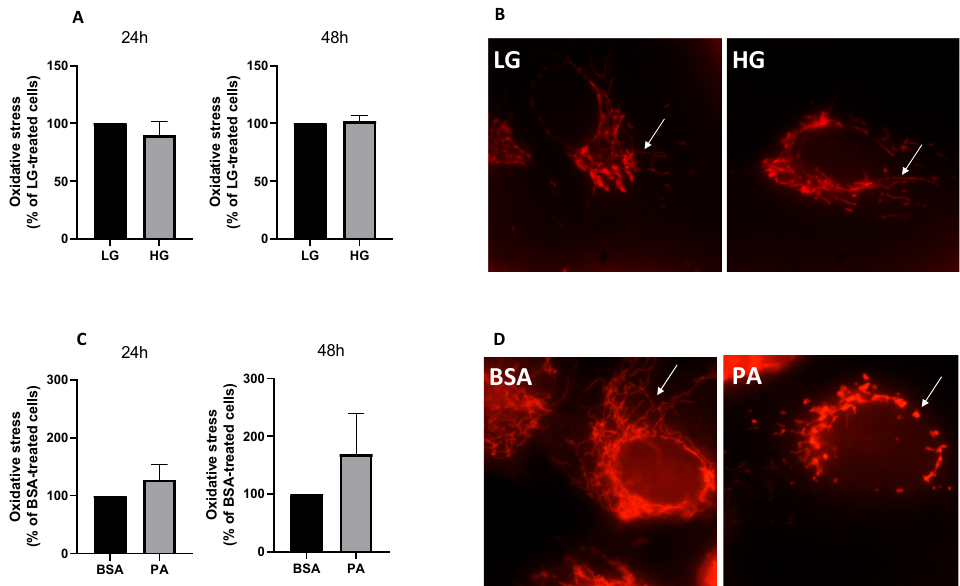
Figure 4. The effect of palmitic acid (PA) on oxidative stress and mitochondrial dynamics. ARPE-19 reactive oxygen species generation in response to 24 or 48 h incubation with low glucose (LG, 5 mM glucose) or high glucose concentration (HG, 13 mM glucose) ( A ) and bovine serum albumin (BSA) or 200 µM PA ( C ). Representative images of ARPE-19 mitochondria stained with MitoTracker TM Red CMXRos following 48 h treatment with LG or HG ( B ) and BSA or PA ( D ). Results are reported as mean ± SEM of at least three independent experiments.